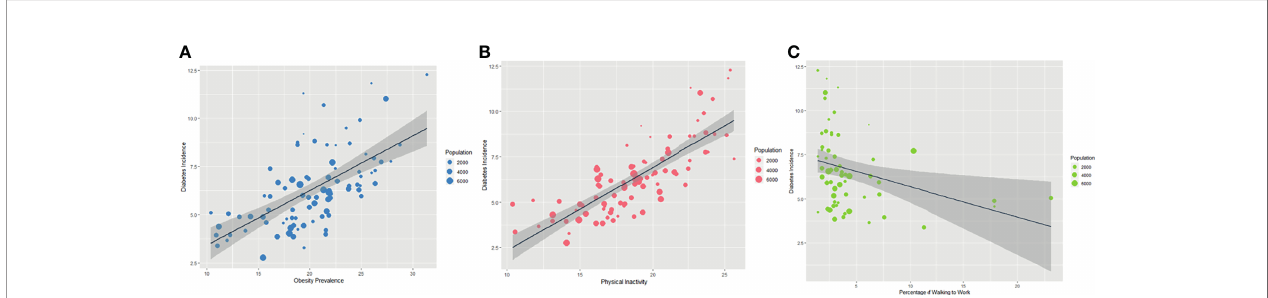
FIGURE 2 | Association in Prevalence of Obesity (A) and Physical Inactivity Rate (B, C) with Incidence of Diabetes (A) shows the correlation between T2DM incidence and obesity prevalence with a spearman correlation coef fi cient of 0.62 (p < 0.001); (B) shows the correlation between T2DM incidence and percentage of the population with insuf fi cient physical activities with a spearman correlation coef fi cient of 0.79 (p < 0.001); (C) shows the correlation between T2DM incidence and percentage of the population walking to work with a spearman correlation coef fi cient of -0.44 (p <